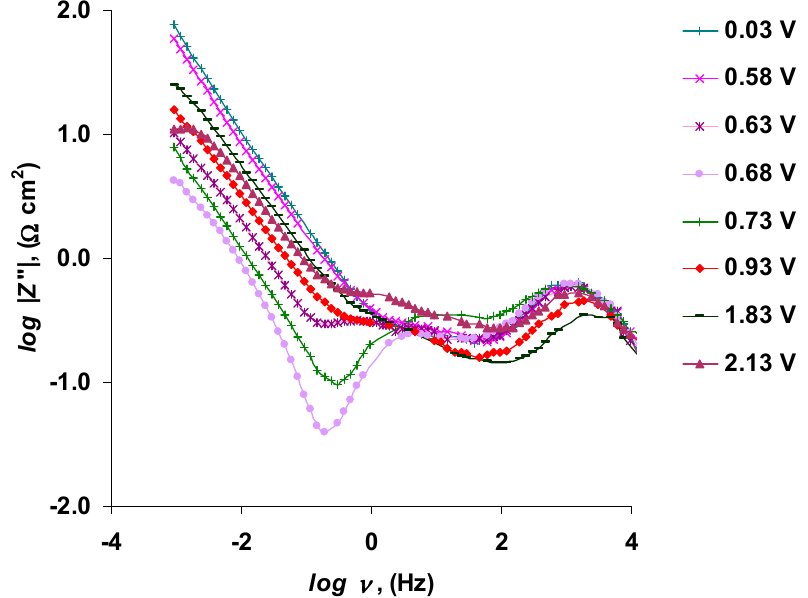
Figure 16. Electrochemical impedance spectroscopy (EIS) data: log of the imaginary part of impedance ( Z” ) vs. log of EIS modulation frequency ( ν ) dependences for the 5 wt % EMImBr solution in the EMImBF 4 –C(Mo 2 C) interface at various positive potentials, noted in the figure.